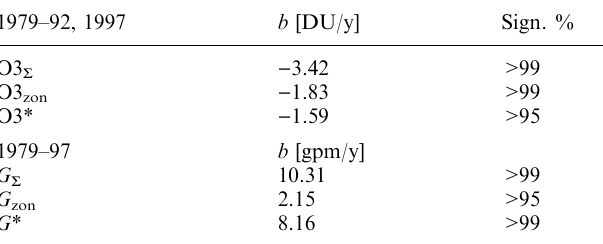
Table 2. Regression coe(cid:129)cients of ozone and geopotential decadal change during 1979–97 at the gridpoint 50 (cid:176) N10 (cid:176) W; b : temporal linear regression coe(cid:129)cient. Sign: significance level. For explana- tion of su(cid:129)ces see Fig.